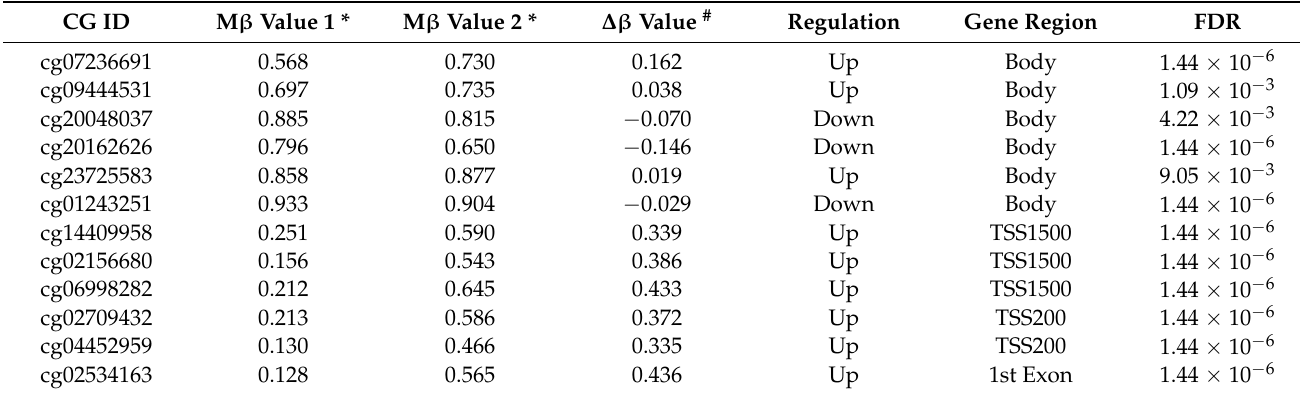
Table 5. Differential methylation and expression analysis of ENPP2 between normal prostate and PC tumors from TCGA cases.